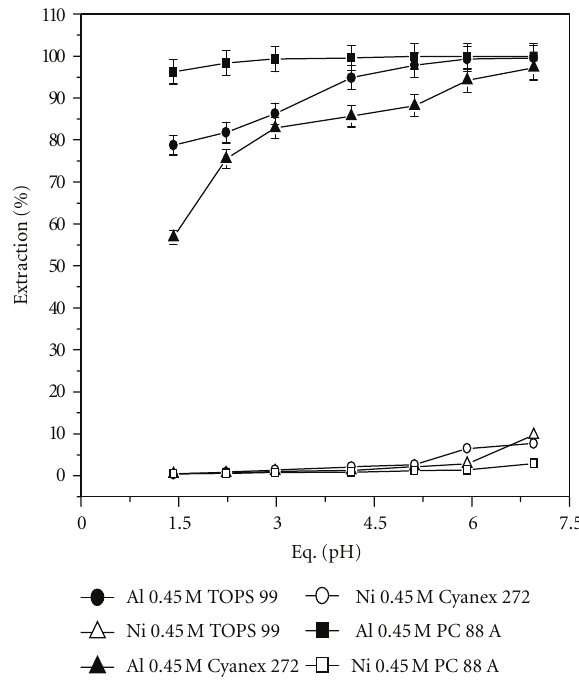
Figure 1: Equilibrium pH on percentage extraction of Al and Ni; conditions: Al = 3.25 g/L; Ni = 85g/L; reagents = 0.45 M; TOPS 99; PC 88 A; Cyanex 272; equilibrium pH,